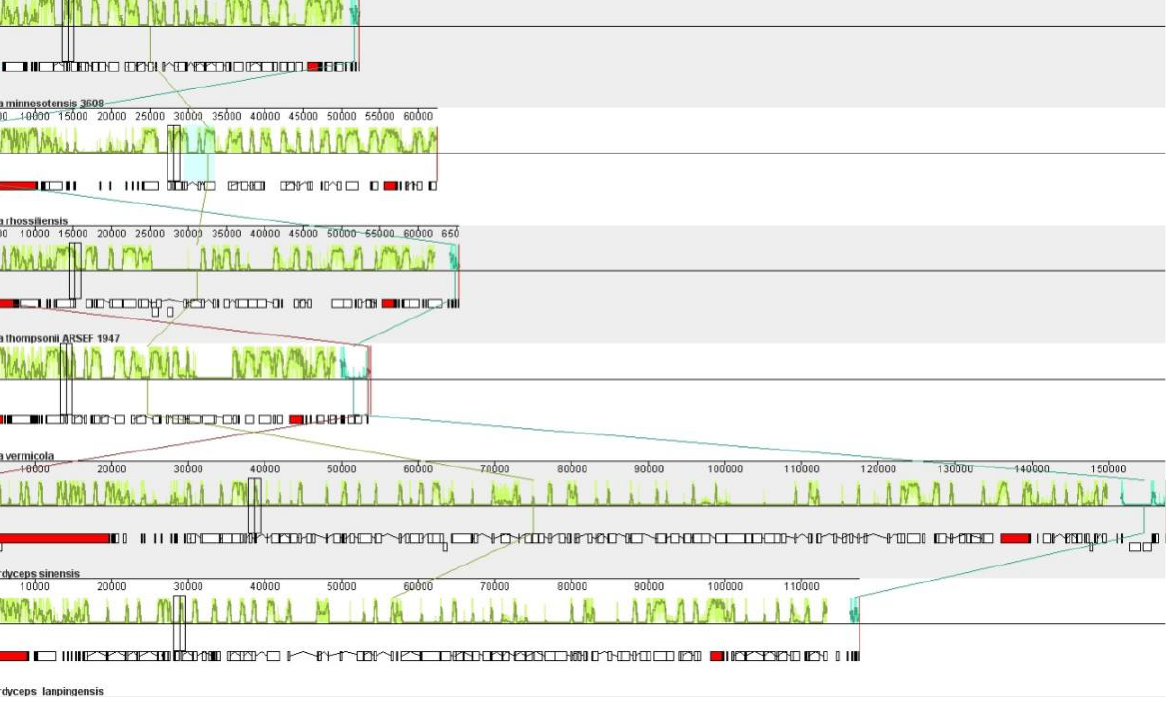
Figure 8. Mitogenome collinearity /synteny progress of six Ophiocordyceps species. Mauve alignment determined the homologous regions of the six mitogenomes, which are connected by colored lines to explain the sequence of gene arrangement. The sizes and relative positions of the homologous fragments varied across the mitogenomes.